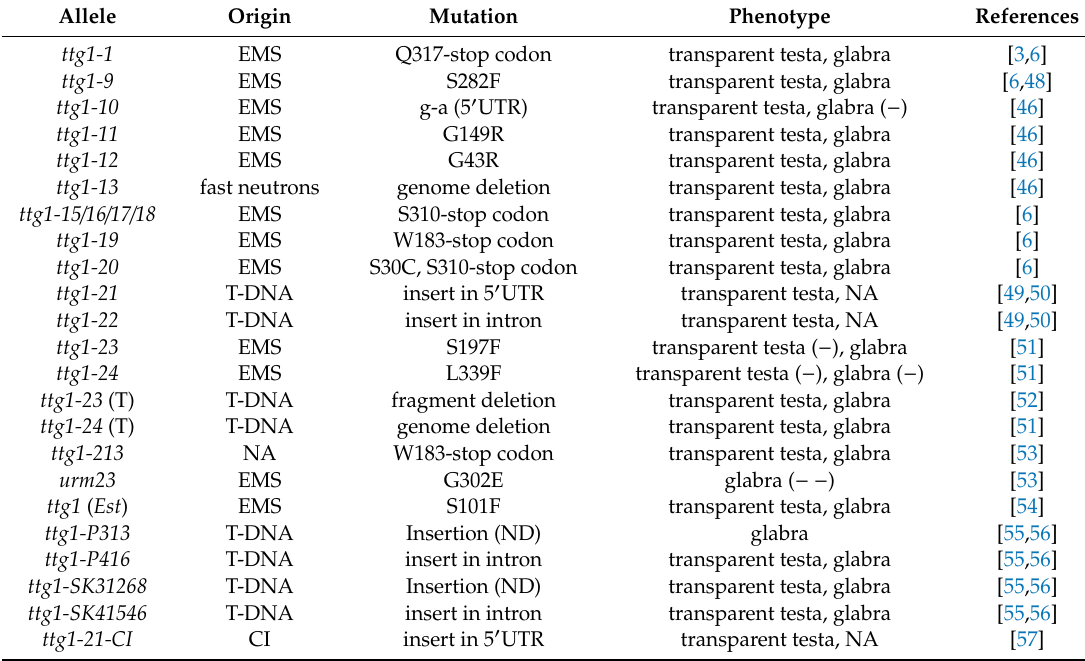
Table 1. The Arabidopsis ttg1 mutants identified so